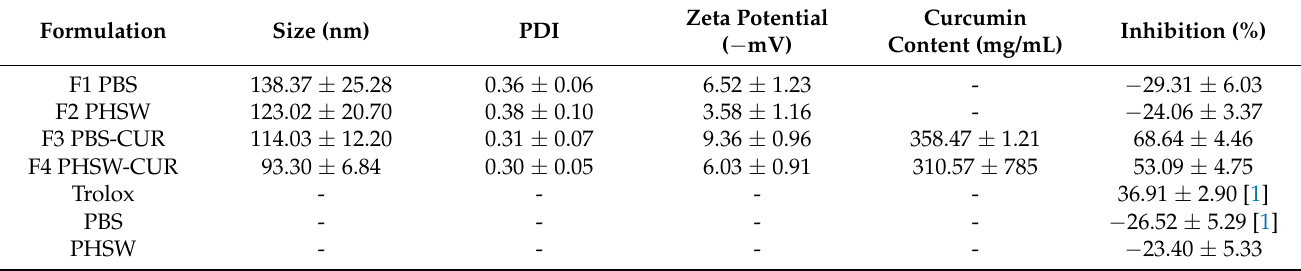
Table 4. The physicochemical characteristics and antioxidant activity of the liposome formulations.